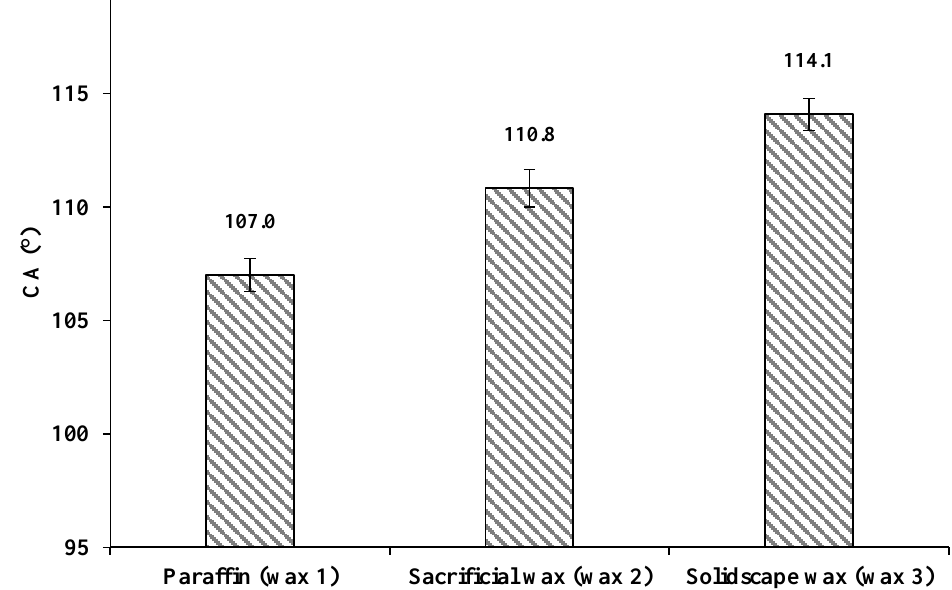
Figure 2. Contact angles of cellulose solution on paraffin (wax 1) 107° ± 0.74°, sacrificial investment casting wax (wax 2) 110.8° ± 0.83° and Solidscape® wax (wax 3) 114.1° ± 0.7°. Abbreviations: CA, contact angle.